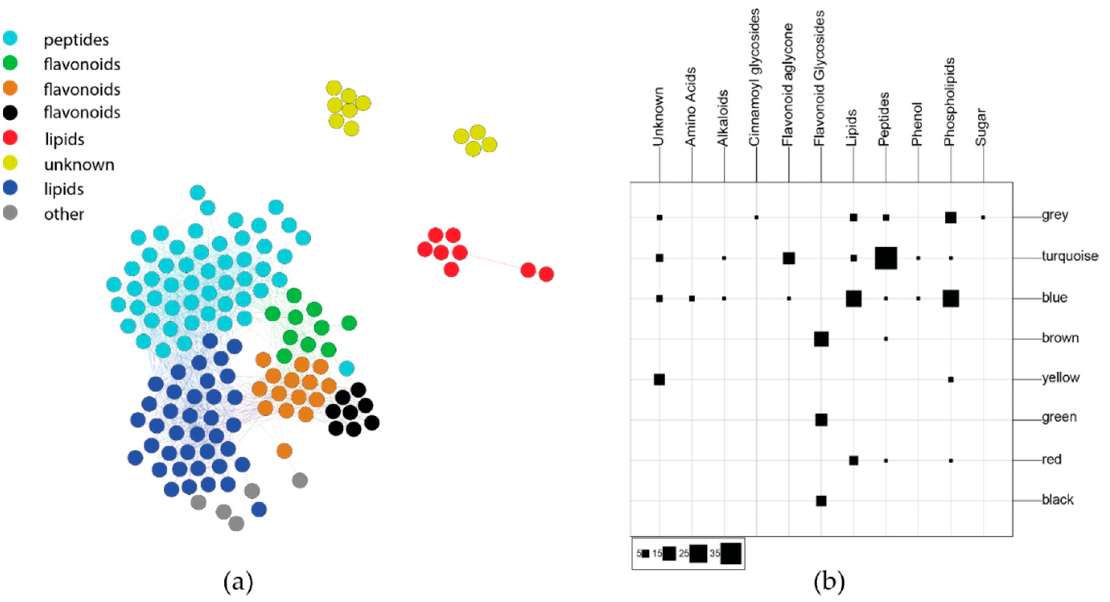
Figure 4. ( a ) WGCNA network of covarying C. velutinus compounds. The brown and green modules represent flavonoid glycosides, while the turquoise module largely represents oligopeptides. ( b ) Confusion matrix comparing WGCNA modules and phytochemical class.